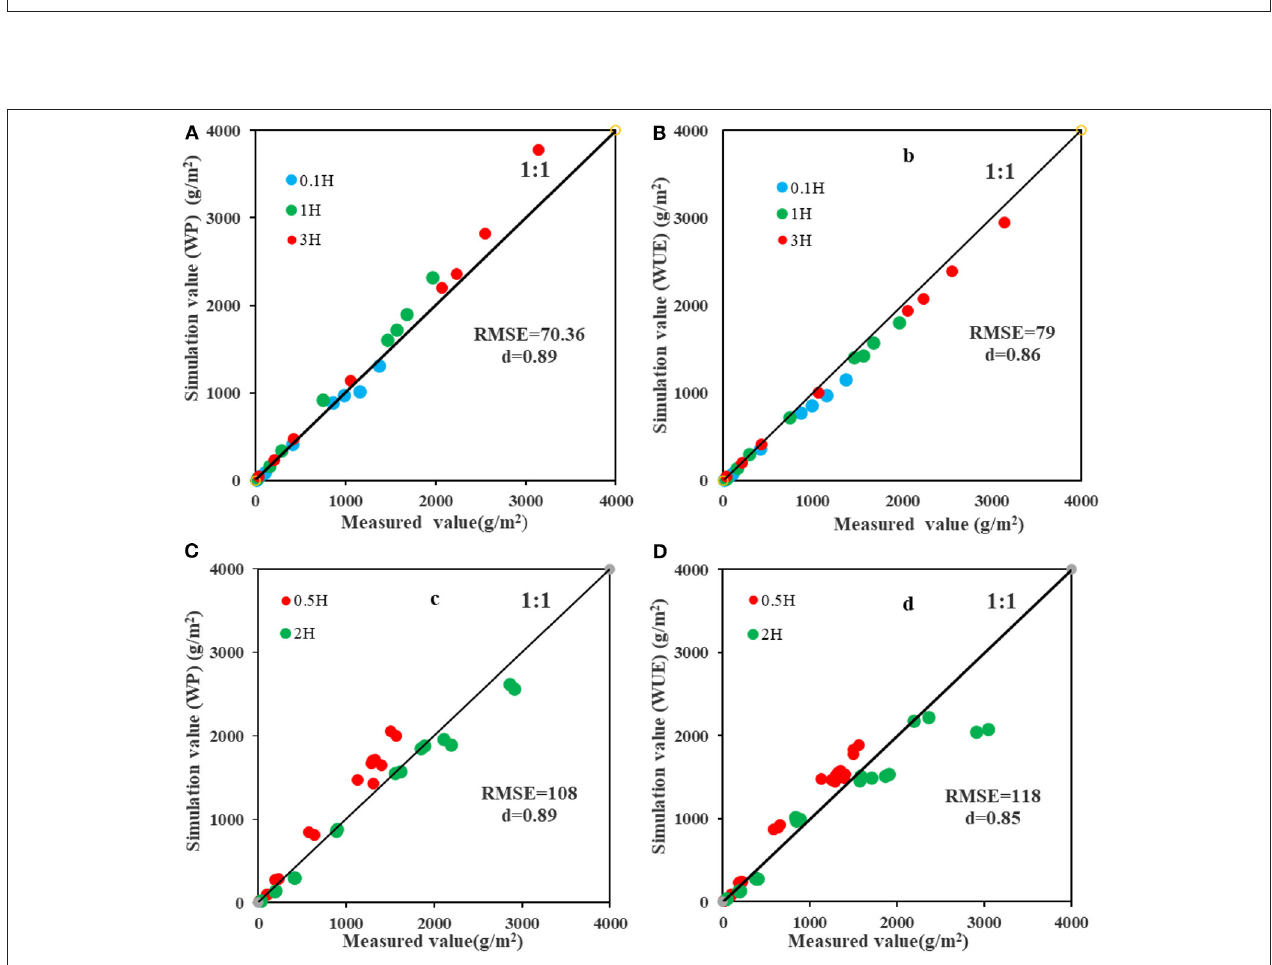
FIGURE 10 | Analysis of the estimation accuracy of the measured and estimated biomass at the sampling areas with different distances from the shelterbelt (0.1H, 0.5H, 1H, 2H, and 3H). (A) Fitting result between measured biomass and estimated biomass based on the estimated WP at 0.1H, 1H, and 3H. (B) Fitting result between measured and estimated biomass based on the estimated WUE at 0.1H, 1H, and 3H. (C) Fitting result between measured and estimated biomass based on the estimated WP at 0.5H and 2H. (D) Fitting result between measured and estimated biomass based on the estimated WUE at 0.5H and 2H.